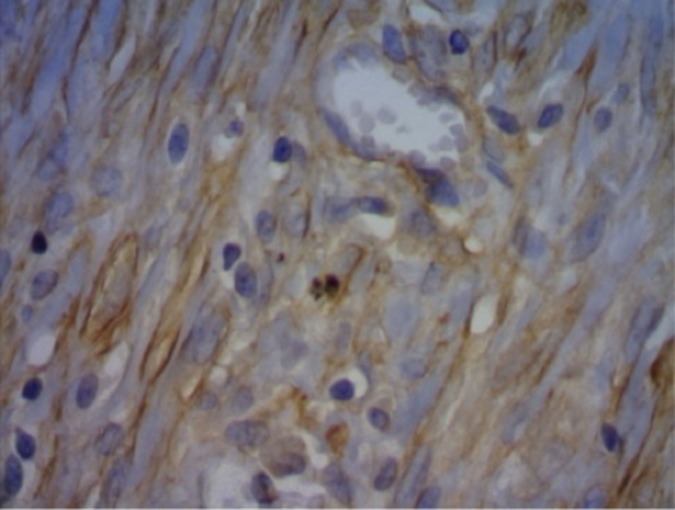
Immunohistochemical staining for experimental group/14 day subset.